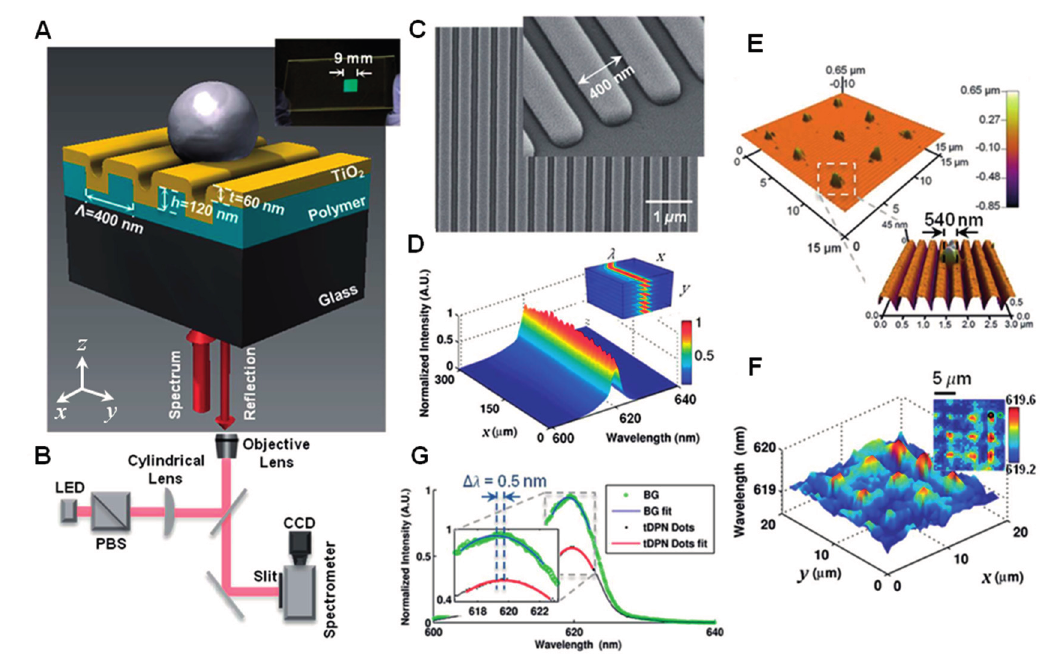
Figure 4. Instrument 3: Reflection acquisition mode of photonic crystal biosensor integrated with an inverted microscope and using LED as light source. ( A ) Schematic of the structure of a photonic crystal (PC) surface biosensor with a surface-attached nanoparticle, inset: photo of a PC biosensor fabricated on a glass slide; ( B ) Instrument schematic of the modern Photonic Crystal Enhanced Microscopy (PCEM); ( C ) Scanning electron micrograph of the photonic crystal surface, inset: zoomed-in image on the edge of the PC biosensor; ( D ) Normalized spectrograph (surface plot) measured with PCEM. Inset: PCEM-acquired 3D spectrum data; ( E ) AFM images of a tDPN-printed 3 × 3 array of nano-dots (each with dimension of 540 2 × 40 nm 3 ), inset: zoomed-in AFM image of one tDPN-printed dot; ( F ) PWV image of the tDPN-printed dots (displayed in a 3D surface plot) within a 20 2 µm 2 field of view, inset: 2D PWV image; ( G ) Normalized spectra of a representative tDPN-printed dot and a background pixel, inset: zoomed-in image of the spectra with 2D polynomial fitting (Reprinted in part with permission from [48], © 2014 RSC